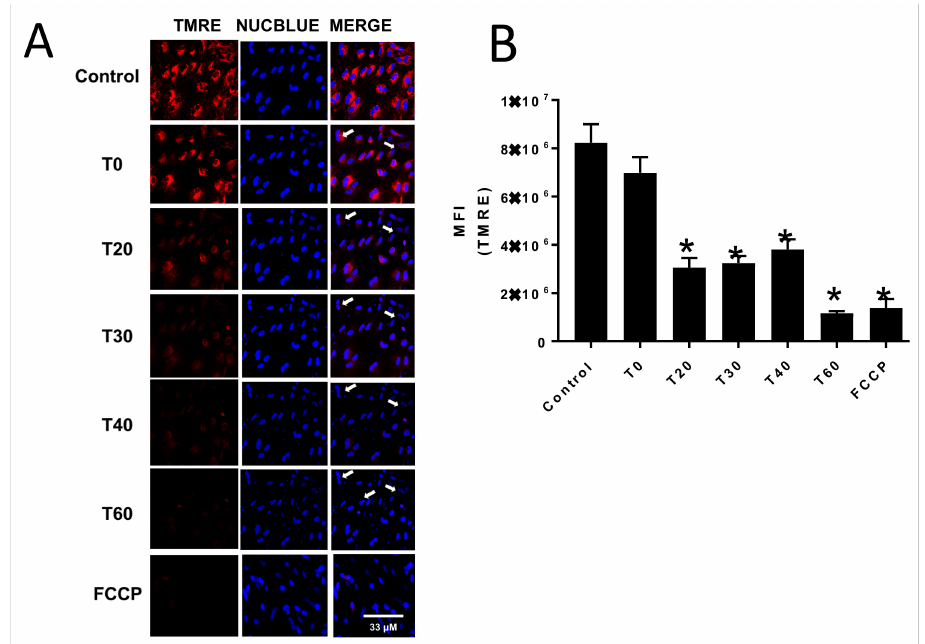
Figure3. Monitoringthee ff ectofE:Conmitochondrialmembranepotentialinwholecellsatvarioustime points. ( A )ConfocalimagesofcontrolandE:C-treated(70 µ